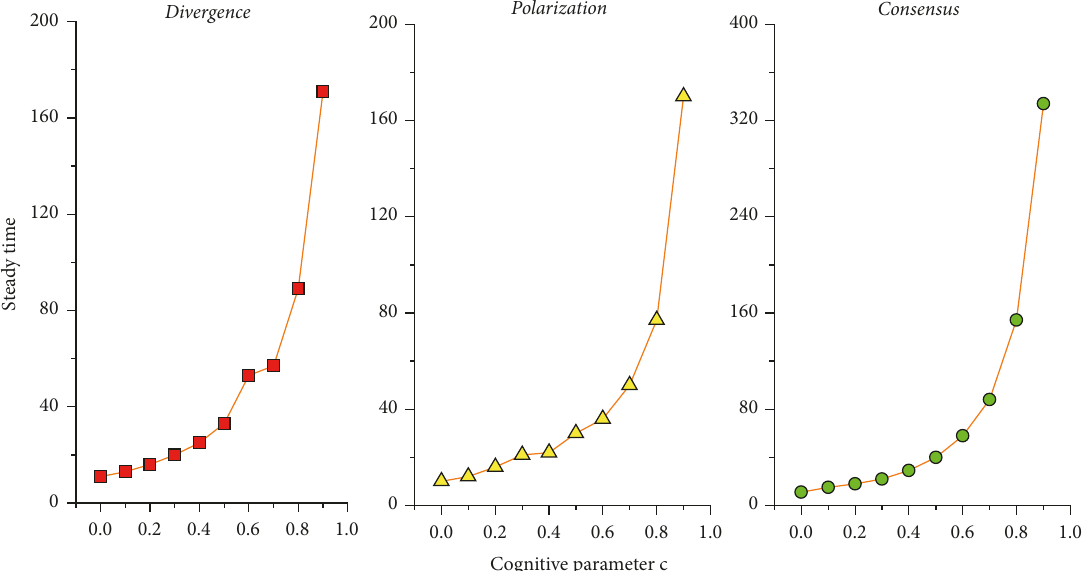
Figure 4: Steady times for the three steady states of the social system (divergence, polarization, and consensus) for different cognitive parameters ( 𝑐